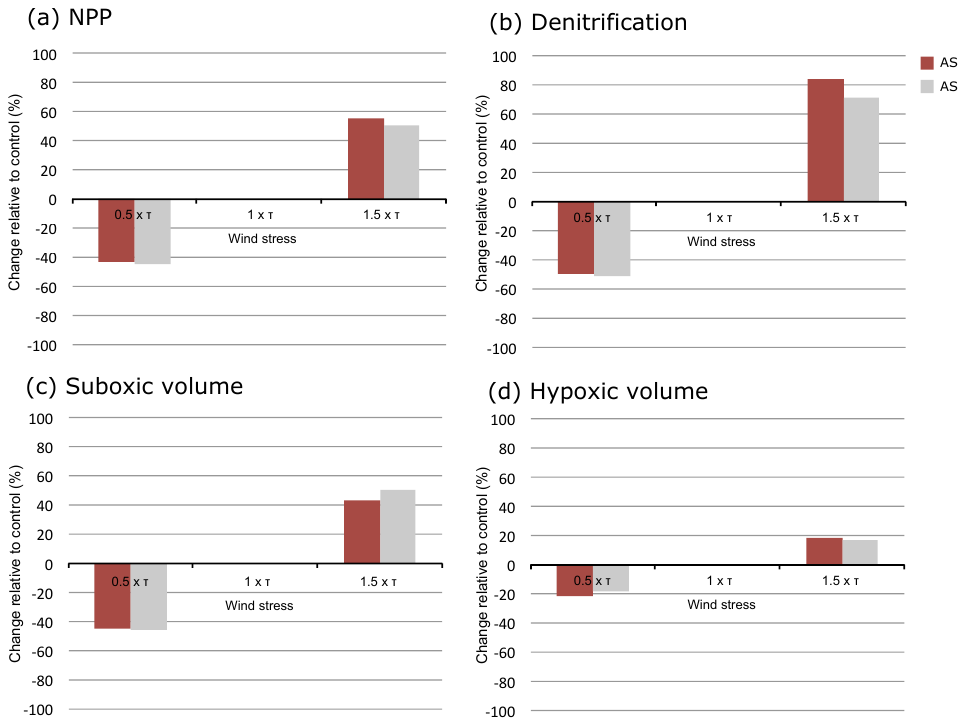
Figure 12. Simulated response to monsoon wind changes as a function of model resolution. Responses of (a) NPP, (b) denitrification, (c) suboxic volume and (d) hypoxic volume to monsoon wind changes as simulated using 1 / 3 (brown) and 1 / 12 ◦ (grey) model